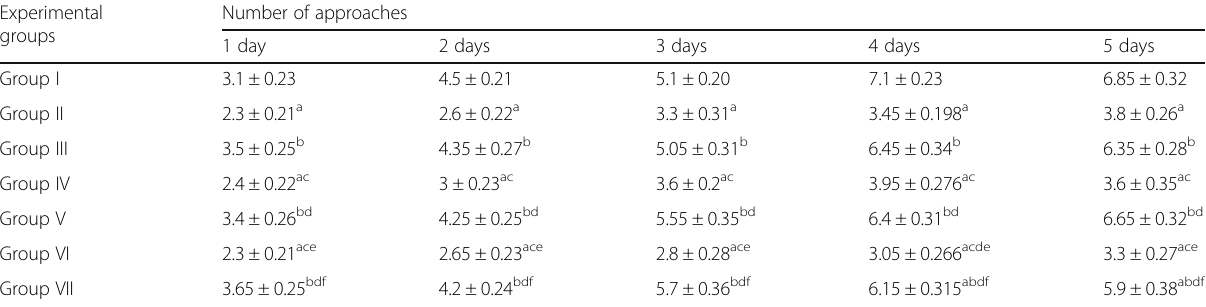
Table 2 The exploratory learning (the number of approaches) in the male offspring of groups I to VII, 70 days postnatal. Data are presented as a mean of eight rats ±